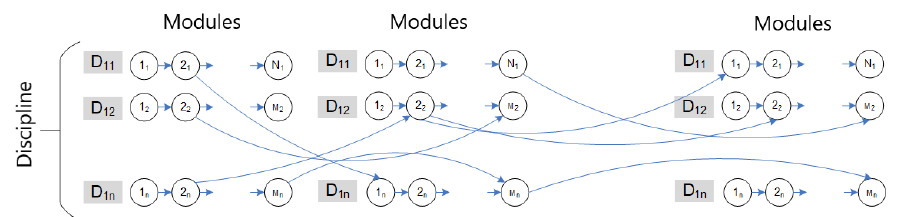
Fig. 1. Graph of curriculum modules grouped into disciplines.